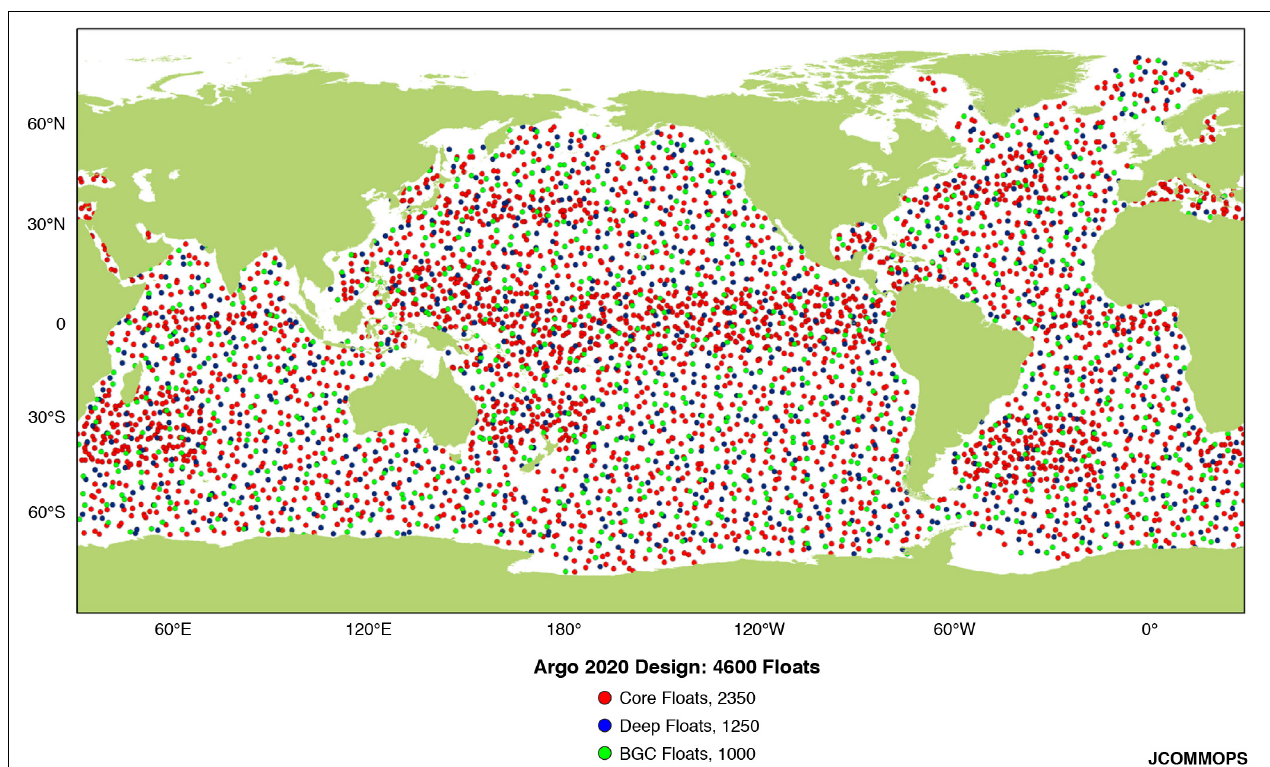
FIGURE 10 | Schematic of the Argo2020 design indicating the density of a total of 4600 floats. including 2350 Core Argo floats (red dots), 1000 BGC-Argo floats (light blue), and 1250 Deep Argo floats (dark blue) floats as indicated in Table 1 . Regions recommended for doubled density (i.e., 2 floats per 3 ◦ square) are noted in Table 1 (Source: JCOMMOPS).